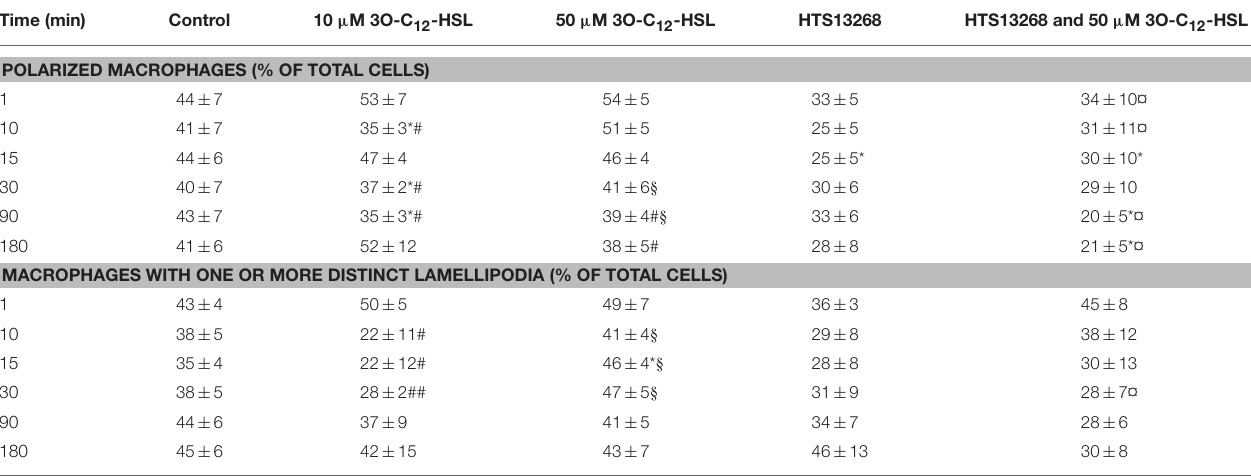
TABLE 1 | Morphological changes in 3O-C 12 -HSL-stimulated macrophages identified by 2D live imaging. Time (min) POLARIZED MACROPHAGES (% OF TOTAL CELLS)